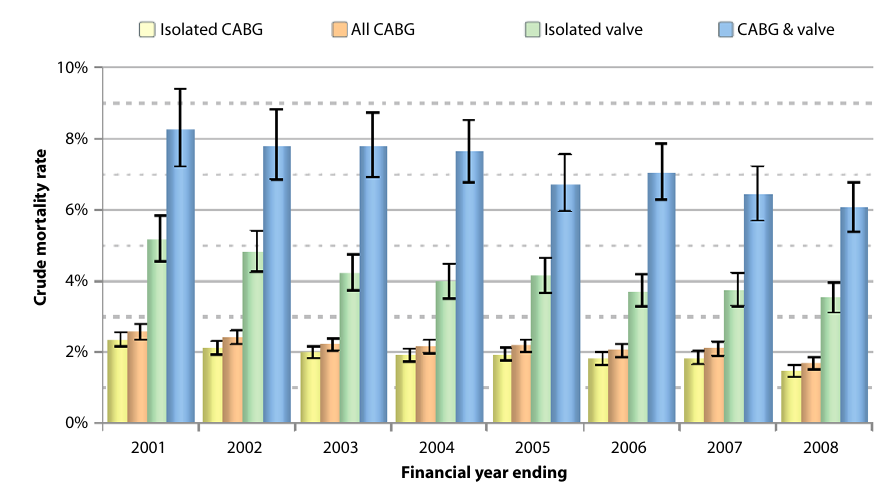
Figure. 1 The graph shows improvements in mortality fn the UK for all the main operative groups over time. IThe degree of improvement is marked; between 2001 and 2008 the rates changed from 2.3% to 1.5% for isolated CABG( χ 2 -test p < 0 . 001 ),2.6%to1.7%( χ 2 -test p < 0 . 001 )forallCABG,5.2%to3.5%forisolatedvalves( χ 2 -test p < 0 . 001 ) and 8.3% to 6.1% ( χ 2 -test p < 0 . 001 ) for combined valve & CABG. These changes were seen